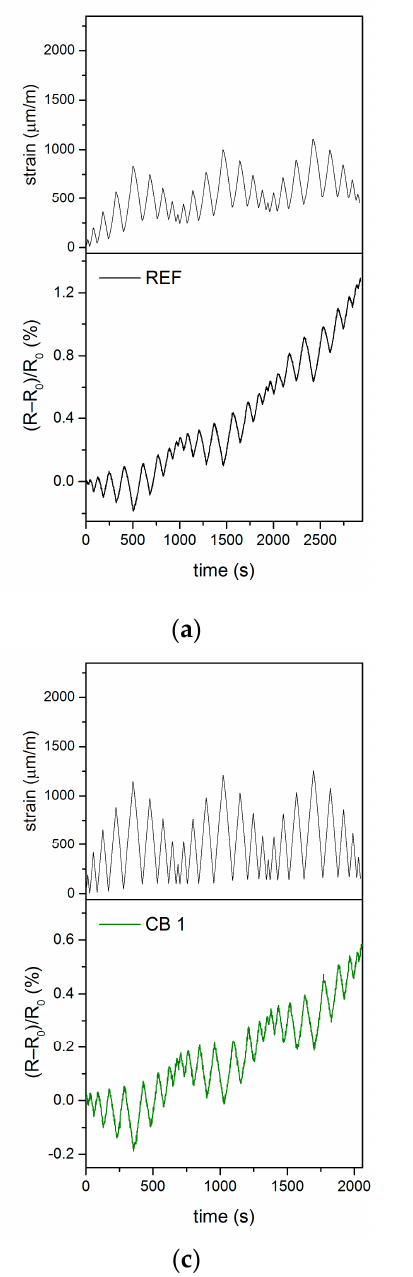
Table 3. Calculated gauge factors.